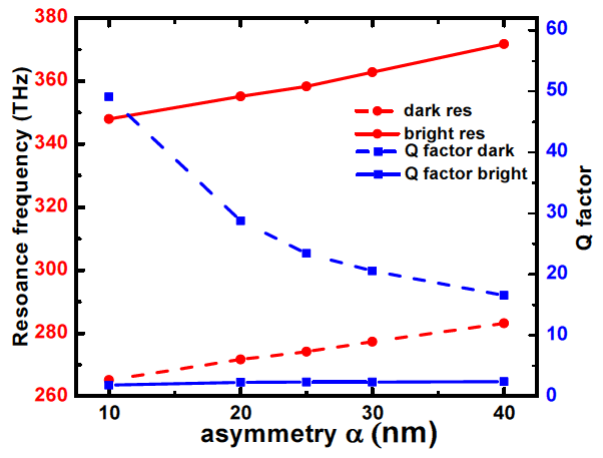
Figure 4. Influence of length asymmetry on resonance (red curves, left) and Q-factor (blue curves, right) for bright (solid lines) and dark (dashed lines)